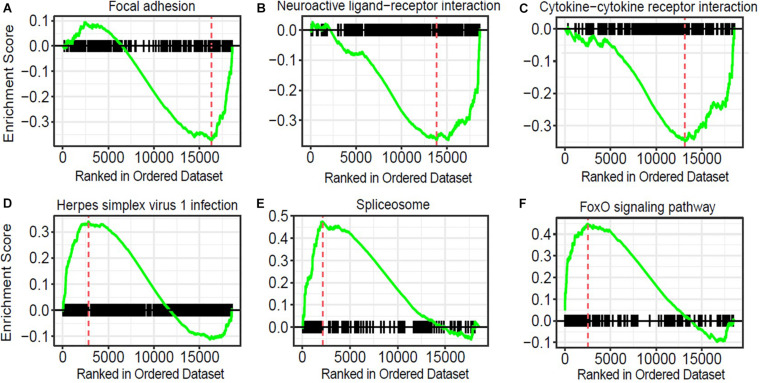
Pathway analysis of genes correlated with manganese (Mn)-deficient cerebellum. Gene sets and their associated enrichment plots generated by gene set enrichment analysis (GSEA) of pre-ranked gene expression data (Padj < 0.05). Enrichment plot with enrichment scores (ES) and differentially expressed genes are shown for (A) focal adhesion, (B) neuroactive ligand-receptor interaction, and (C) cytokine–cytokine receptor interaction, (D) herpes simplex virus 1 infection, (E) spliceosome, and (F) FoxO signaling pathway. The X-axis denotes the position of the pathway genes in all analyzed genes, which are ranked in an order based on fold changes (high to low) by Mn deficiency. The enrichment score is shown as a curve, and the vertical red bars in the plot indicate the position of the “leading edge” of the enrichment. For downregulated pathways (A–C), the genes with higher rank orders than the red line, on the right side of the red line, contributed to the downregulation of the three pathways. Conversely, for the upregulated pathways (D–F), the genes with lower rank orders, on the left side of the red line, contributed to their upregulations.